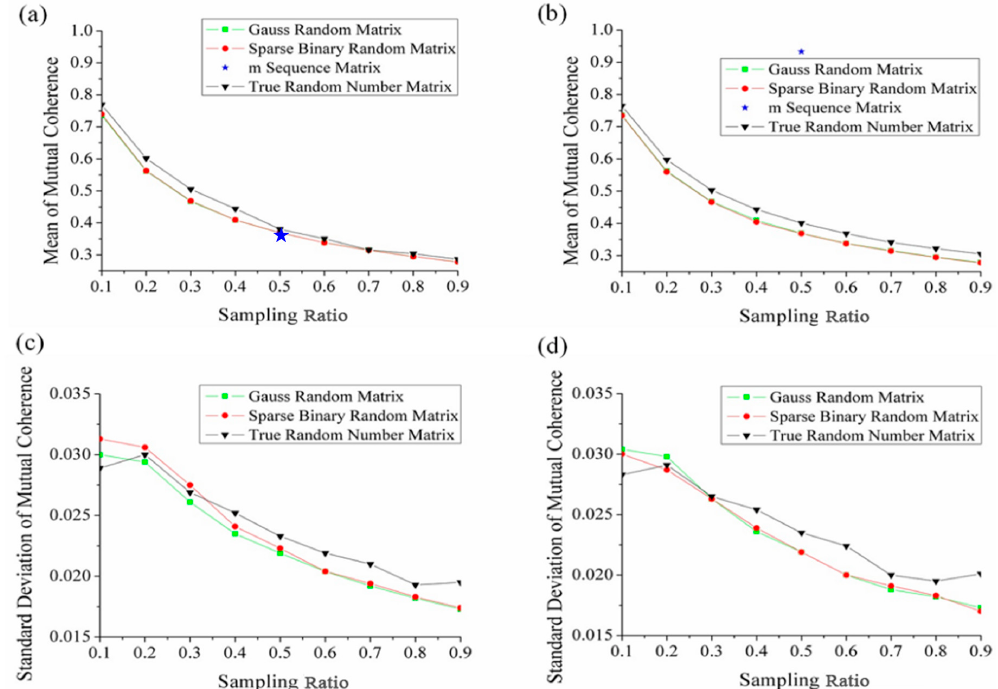
Figure 2. The test results of mutual coherence of the sensing matrices composed by Gauss random matrix, sparse binary random matrix, m sequence matrix and true random number matrix. 10,000 times’ independent experiments are performed on each test point. ( a ) and ( b ) are the mean values of mutual coherence versus sampling ratio when the sparse basis is a discrete cosine basis and a wavelet base respectively. ( c ) and ( d ) are the standard deviation of mutual coherence versus sampling ratio when the sparse basis is a discrete cosine basis and a wavelet base respectively.